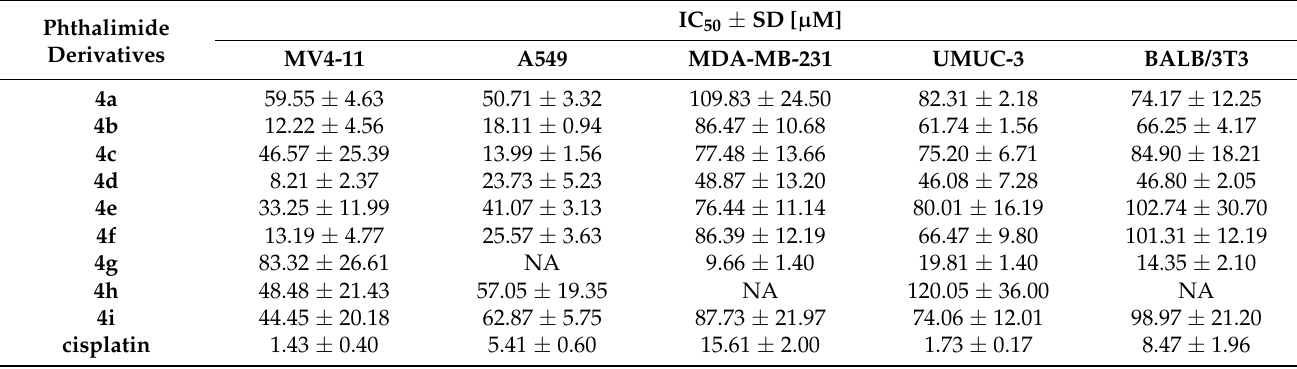
Table 3. Antyproliferative activity of compounds 4a – 4i against human biphenotypic B myelomono- cytic leukemia (MV4-11), lung carcinoma (A549), human breast adenocarcinoma (MDA-MB-231), human bladder transitional cell carcinoma (UMUC-3) and normal mouse fibroblast BALB/3T3 cells.